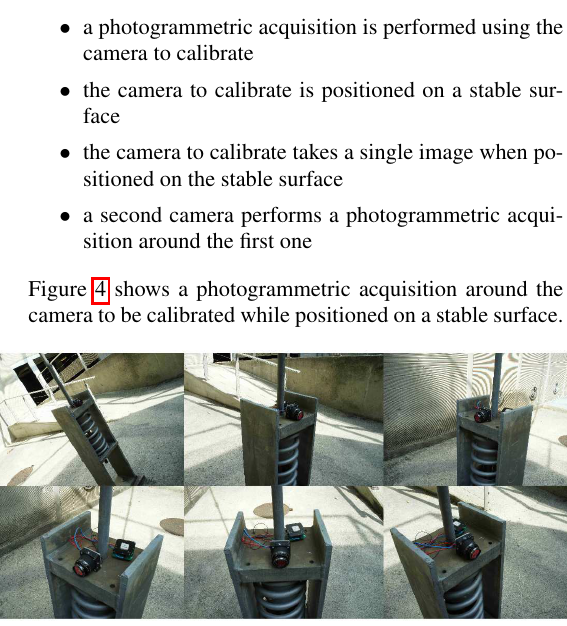
Figure 4: Photogrammetric acquisition around the UAV on-board